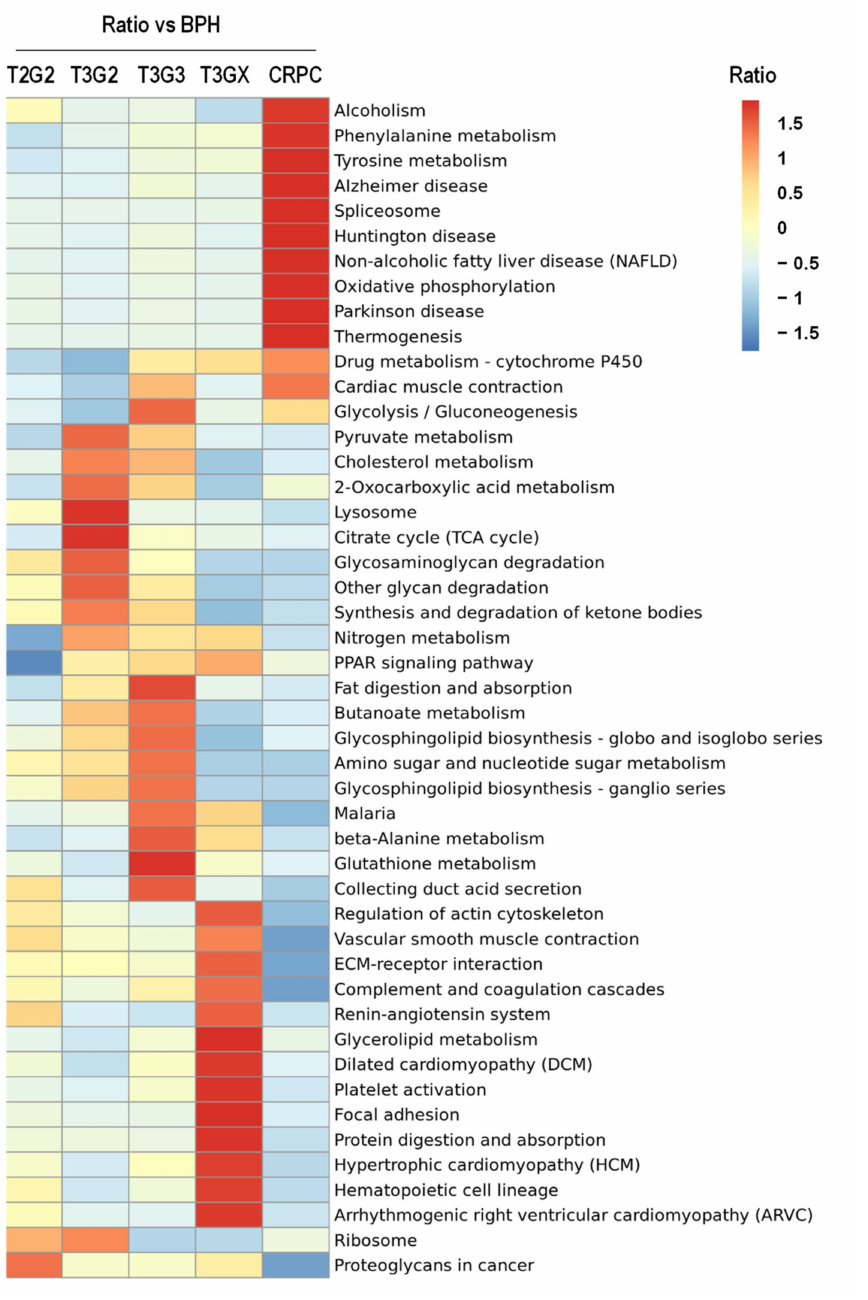
Figure 2. A comprehensive heatmap for cluster analysis of the enrichment patterns for the Kyoto Encyclopedia of Genes and Genomes pathway. The horizontal axis is the different protein grouping, and the vertical axis is the different functional classification. The red to blue gradient color represents the enrichment p -value (<0.05) of the protein grouping in the specified functional classification. Red represents significant enrichment, while blue represents no significant